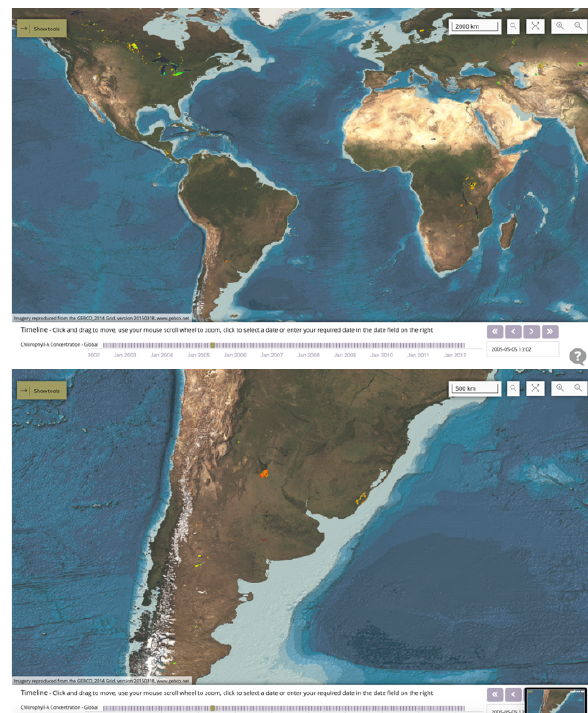
Figure 5. Snapshot of WebGIS platform developed by Plymouth Marine Laboratory for global water quality (https://globolakes.eofrom.space).